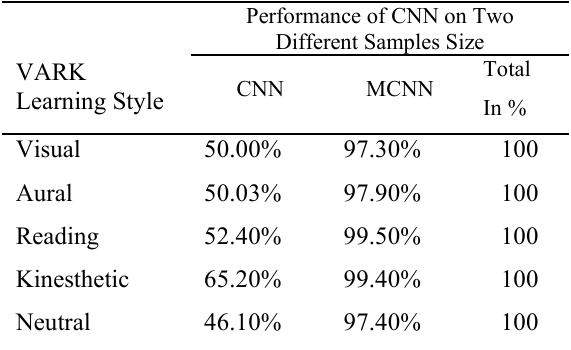
Table 1. Summary of VARK learning style dimensions